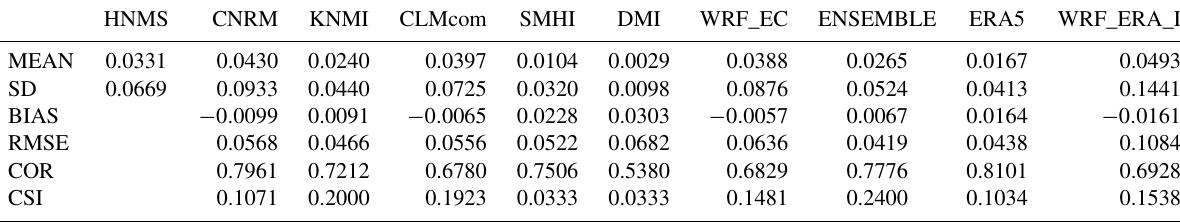
Table 6. Table exhibiting mean (MEAN) RR20ID empirical probabilities station probabilities (%) for observations and models, standard deviation (SD), bias (BIAS), rmse (RMSE), Pearson correlation (COR), and CSI of models against observations.